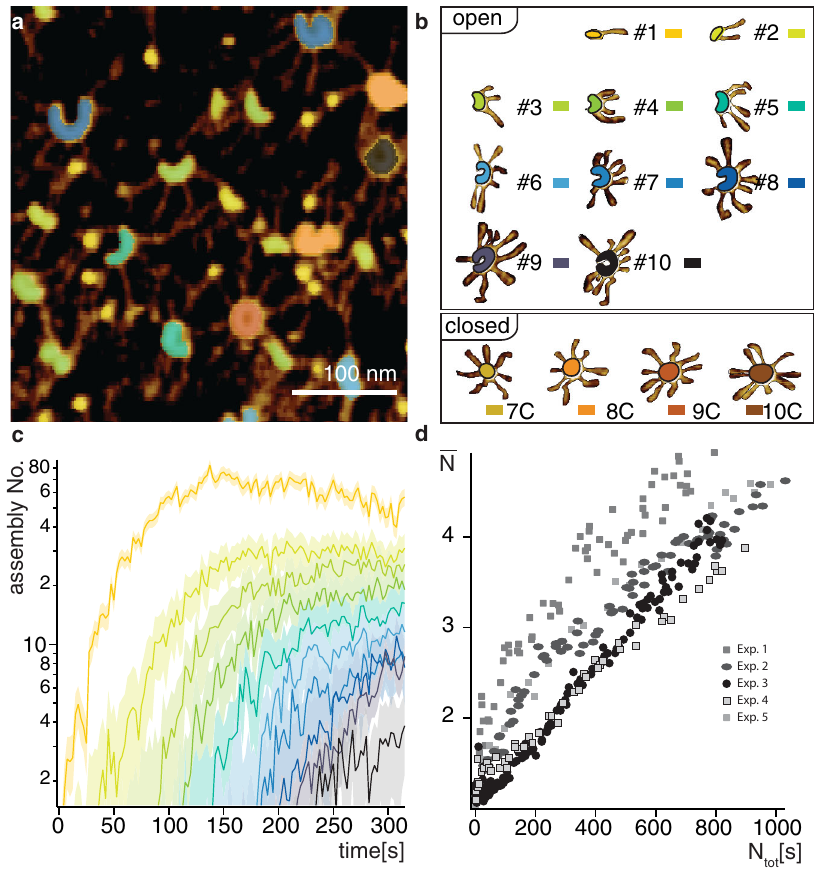
Fig. 3 Machine learning aided classi fi cation of surface SAS-6 self-assembly. a Distinct oligomeric states recognized by machine learning aided classi fi cation in PORT-HS-AFM data. b Representative examples of existing classes. In total there are 10 open and 4 closed conformations, some of which are present in the image shown in panel a . c Number of assemblies of each oligomeric species over time (thin lines, colors as in panel B) in one PORT-HS- AFM experiment. d Average oligomerization degree ( (cid:1) N ) as a function of the total number of homodimers on the mica surface for 5 experiments (see Supplementary Fig. 3 for individual time traces). Note similar slopes, re fl ecting analogous oligomerization